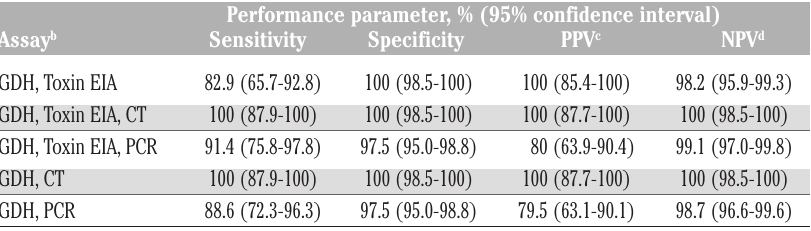
Table 3. Performance characteristics of different C. difficile testing algorithms compared to a combined standard. a Performance parameter, % (95% confidence interval) Assay